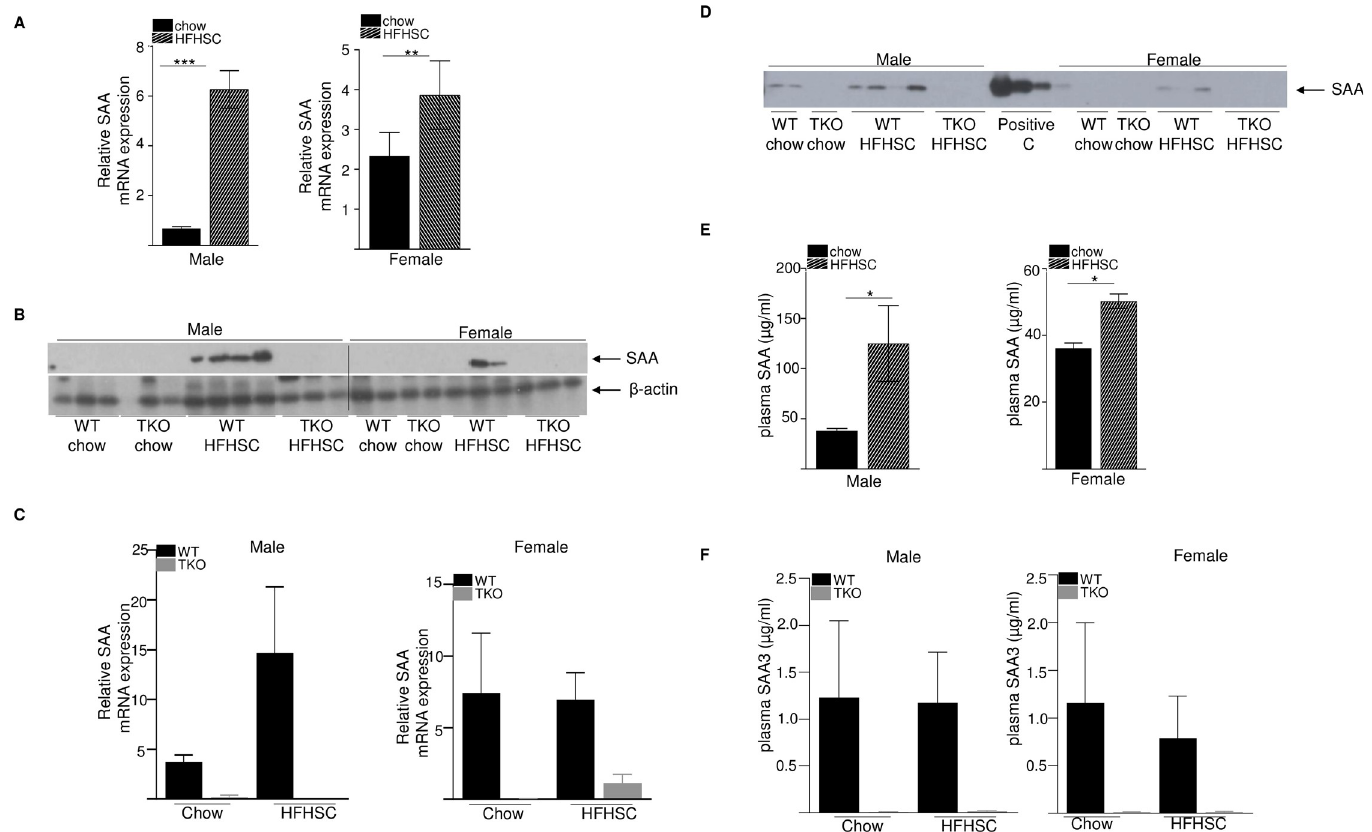
Fig 2. SAA expression is significantly induced in the adipose tissues of obese mice. A) SAA mRNA abundance in gonadal adipose tissue from chow and HFHSC fed WT male (left panel) and female (right panel) mice after 16 weeks of diet feeding (n = 5 mice/group) B) Adipose tissue lysates (50 μ g protein/lane) obtained from WT and TKO mice at the end of the study were immunoblotted for SAA (top panel) and β -actin as loading control (bottom panel). SAA proteins were undetectable in the adipose tissues of chow fed WT mice and all TKO mice. C) SAA mRNA abundance in liver tissue from chow and HFHSC fed WT and TKO male (left panel) and female (right panel) mice after 16 weeks of diet feeding (n = 4–5 mice/group). D) Plasma SAA in WT and TKO mice at the end of the study by western blot. 1 μ l plasma was used/lane. E) SAA levels by elisa in chow and HFHSC fed WT male and female mice after 16 weeks of diet feeding. F) plasma SAA3 levels by elisa in chow and HFHSC fed WT male and female mice after 16 weeks of diet feeding. Data are mean ± SEM; � = P � 0.05, �� = P � 0.01 and ��� = P �